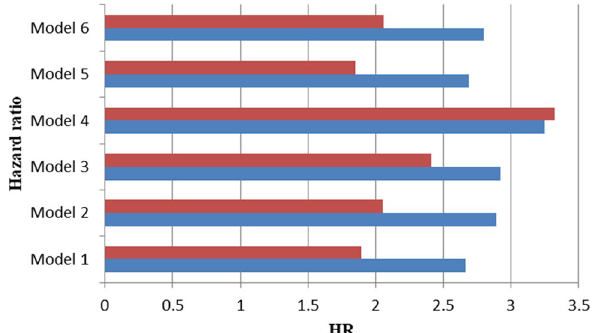
Figure 3. Cox regression of the risk scores of each model on predicting the risk of relapse for breast cancer patients. Red bars are the hazard ratio (HR) of categorical risk scores of each model; blue bars are the hazard ratio (HR) of continuous risk scores of each model.